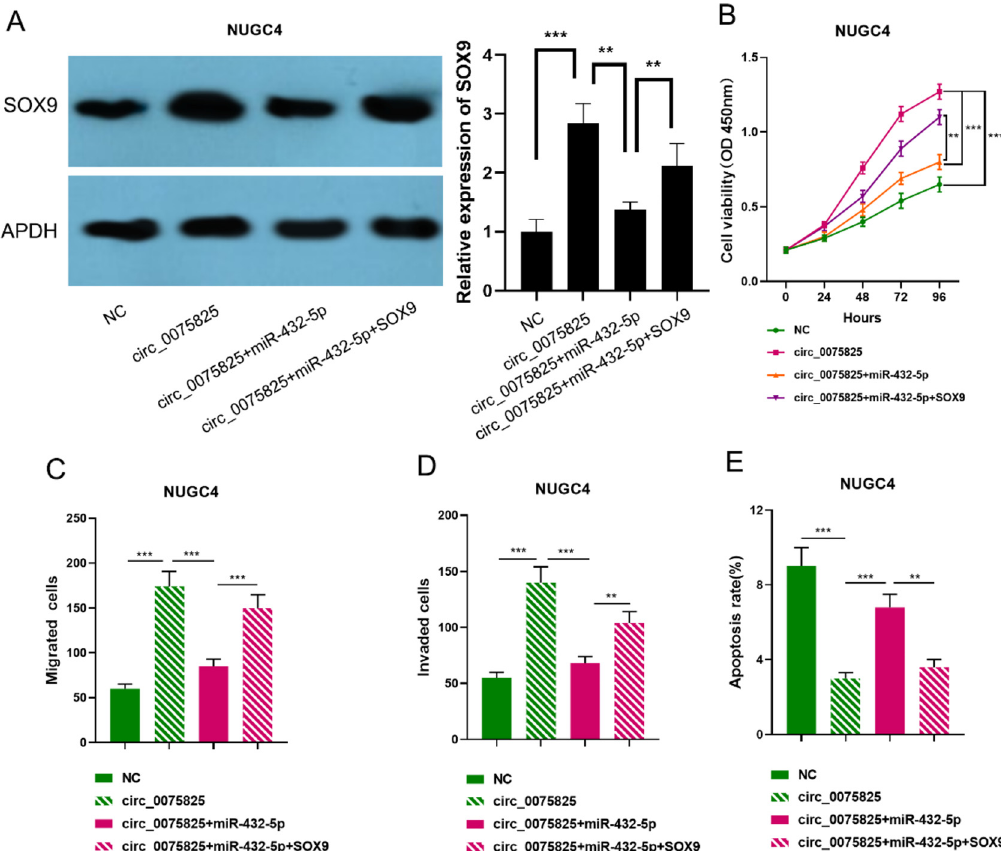
Fig. 5. Circ_0075825 promotes malignant phenotypes of GC cells by regulating miR-432-5p / SOX9 axis. (A) NUGC4 cells with circ_0075825 overexpression were transfected with miR-432-5p mimics and SOX9 overexpression vector, and the protein expression of SOX9 in GC cells was detected by western blot assay. (B) CCK-8 assay was used to detect the proliferation of NUGC4 cells after the transfection. (C-D) Transwell assay was used to detect the migration and invasion of NUGC4 cells after the transfection. (E) Flow cytometry assay was used to detect the apoptosis of NUGC4 cells after the transfection. ** p < 0.01, and *** p <